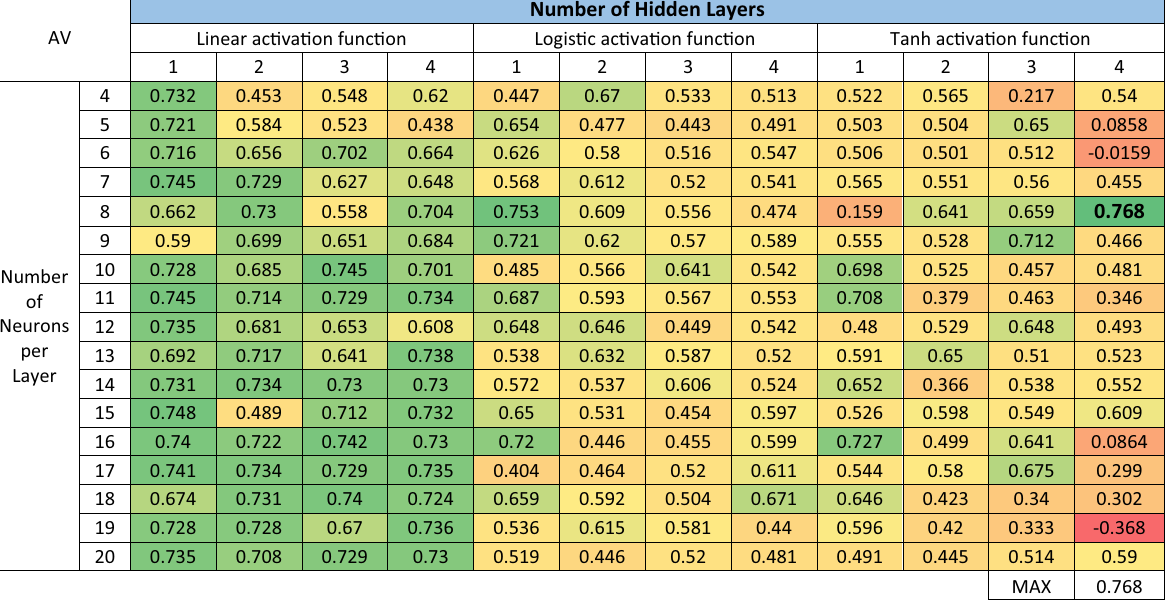
Table 6 Coefficient of correlation for different ANN architectures in the prediction of the density value testing set Number of Hidden Layers AV Linear ac(cid:31)va(cid:31)on